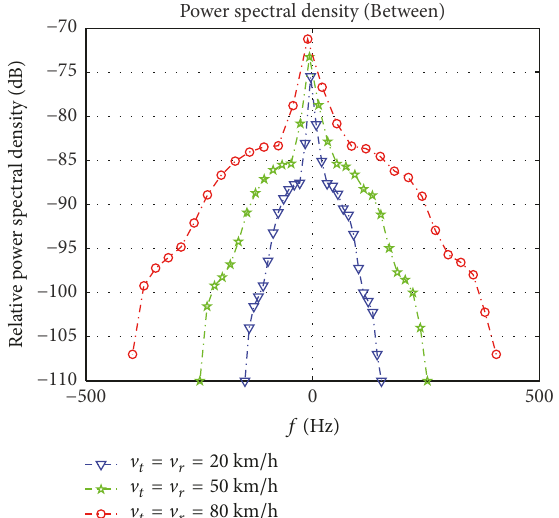
Figure 8: Behavior of PSD 𝑆(𝑓) presented in (10) and Figure 3(c) for V2V scenarios with different moving speeds of Tx/Rx